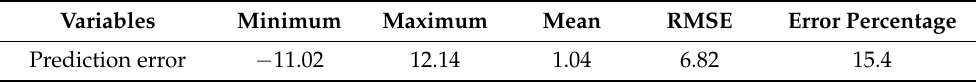
Table 9. Descriptive statistics of errors between actual and BNN predicted values for the test data.